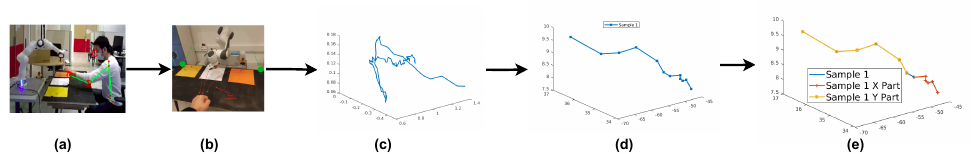
Figure 4. ROS based controller architecture to enable collaboration between humans and robots in shared environments.